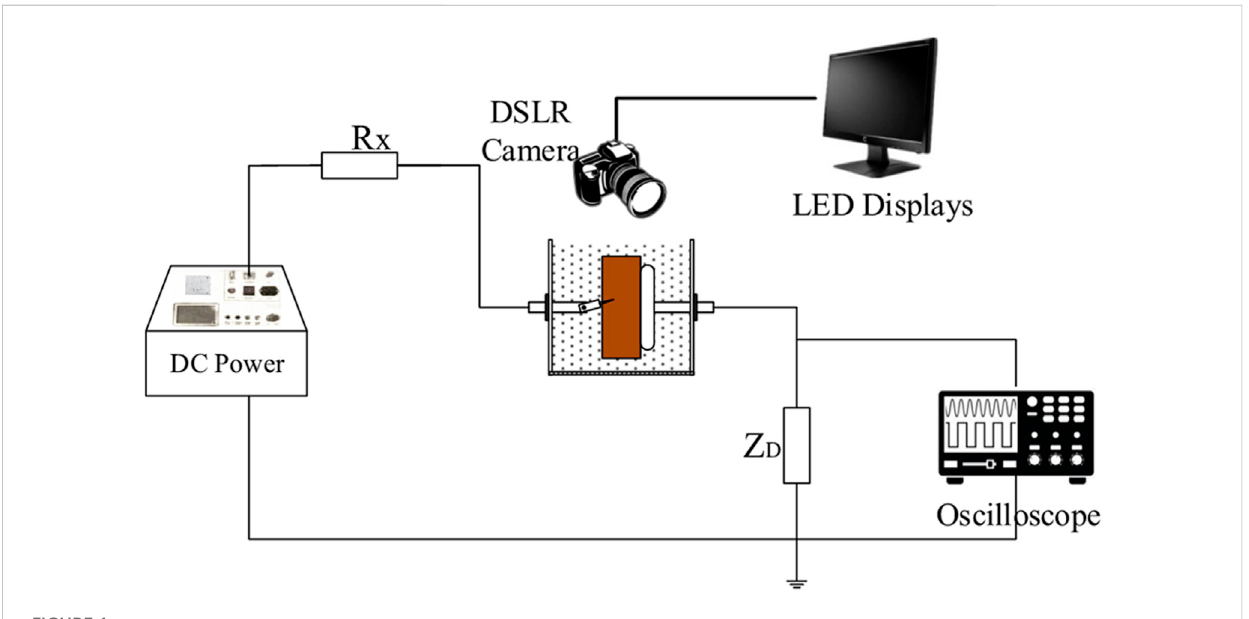
FIGURE 1 Schematic diagram of partial discharge test